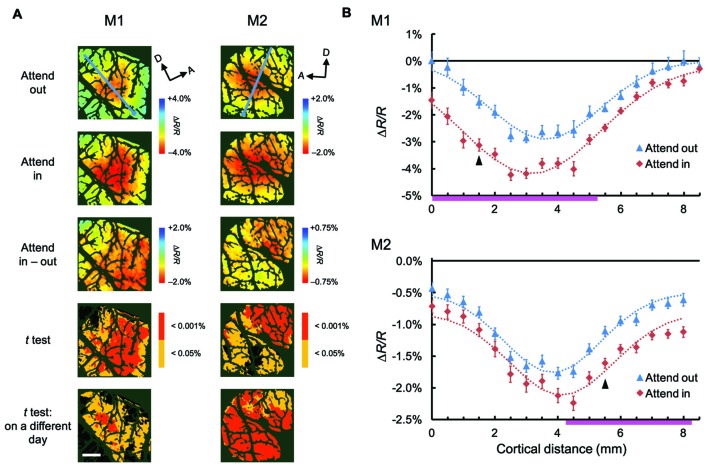
Spatial distribution of attentional effects on global signals of hemodynamic responses. (A) The first two rows show maps of stimulus-evoked reflectance changes averaged across all stimuli for both animals (global signals; M1, left; M2, right) under attend-out (first row) and attend-in (second row) conditions. The third row shows the difference maps between attend-in and attend-out conditions. The fourth row shows statistical maps in which regions with a significant difference in reflectance change between attend-in and attend-out conditions are color-coded according to the level of significance (P value). Regions exhibiting a larger decrease in reflectance under attend-in and attend-out conditions are colored in yellow/red and cyan/blue, respectively. The bottom row shows other statistical maps constructed using the same method as in the fourth row, but from data acquired 10 days (left) and 2 days (right) later, to illustrate the reproducibility of the attentional enhancements. Scale bar represents 1 mm. (B) Plots of average reflectance changes in the imaging session shown in the first row of (A), sampled along the lines across the cortical surface for both animals (M1, top; M2, bottom), nearly parallel to the lunate sulcus, as indicated by the cyan lines in the top panels of (A). The sampling points were selected every 1 mm, starting from the ventral ends of lines, as indicated by the cyan dots in (A), which correspond to the distance 0 on the x axis. Error bars represent SEM. The range of points showing significant differences between the two plots (attend-out vs. attend-in) is indicated by the pink thick lines along the x axis. For each attentional condition and animal, Gaussian curves were fitted to the plots and are shown as dotted lines (all R2 values were above 0.94). Arrowheads indicate the sampling points giving the maximal difference between the two fitted curves under attend-out and attend-in conditions for each animal.